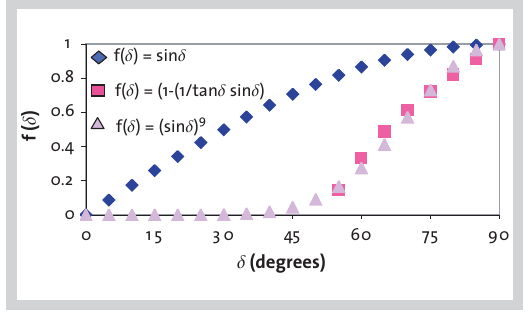
Figure 1: Comparison of the various functions of d